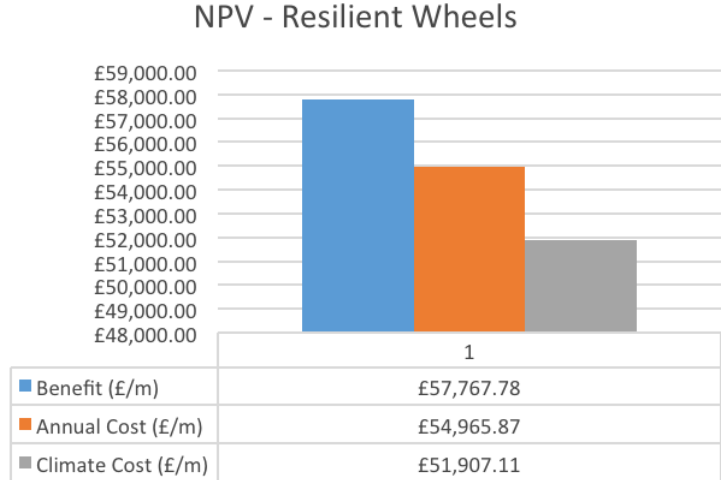
Figure 12. Net present values for resilient wheels.